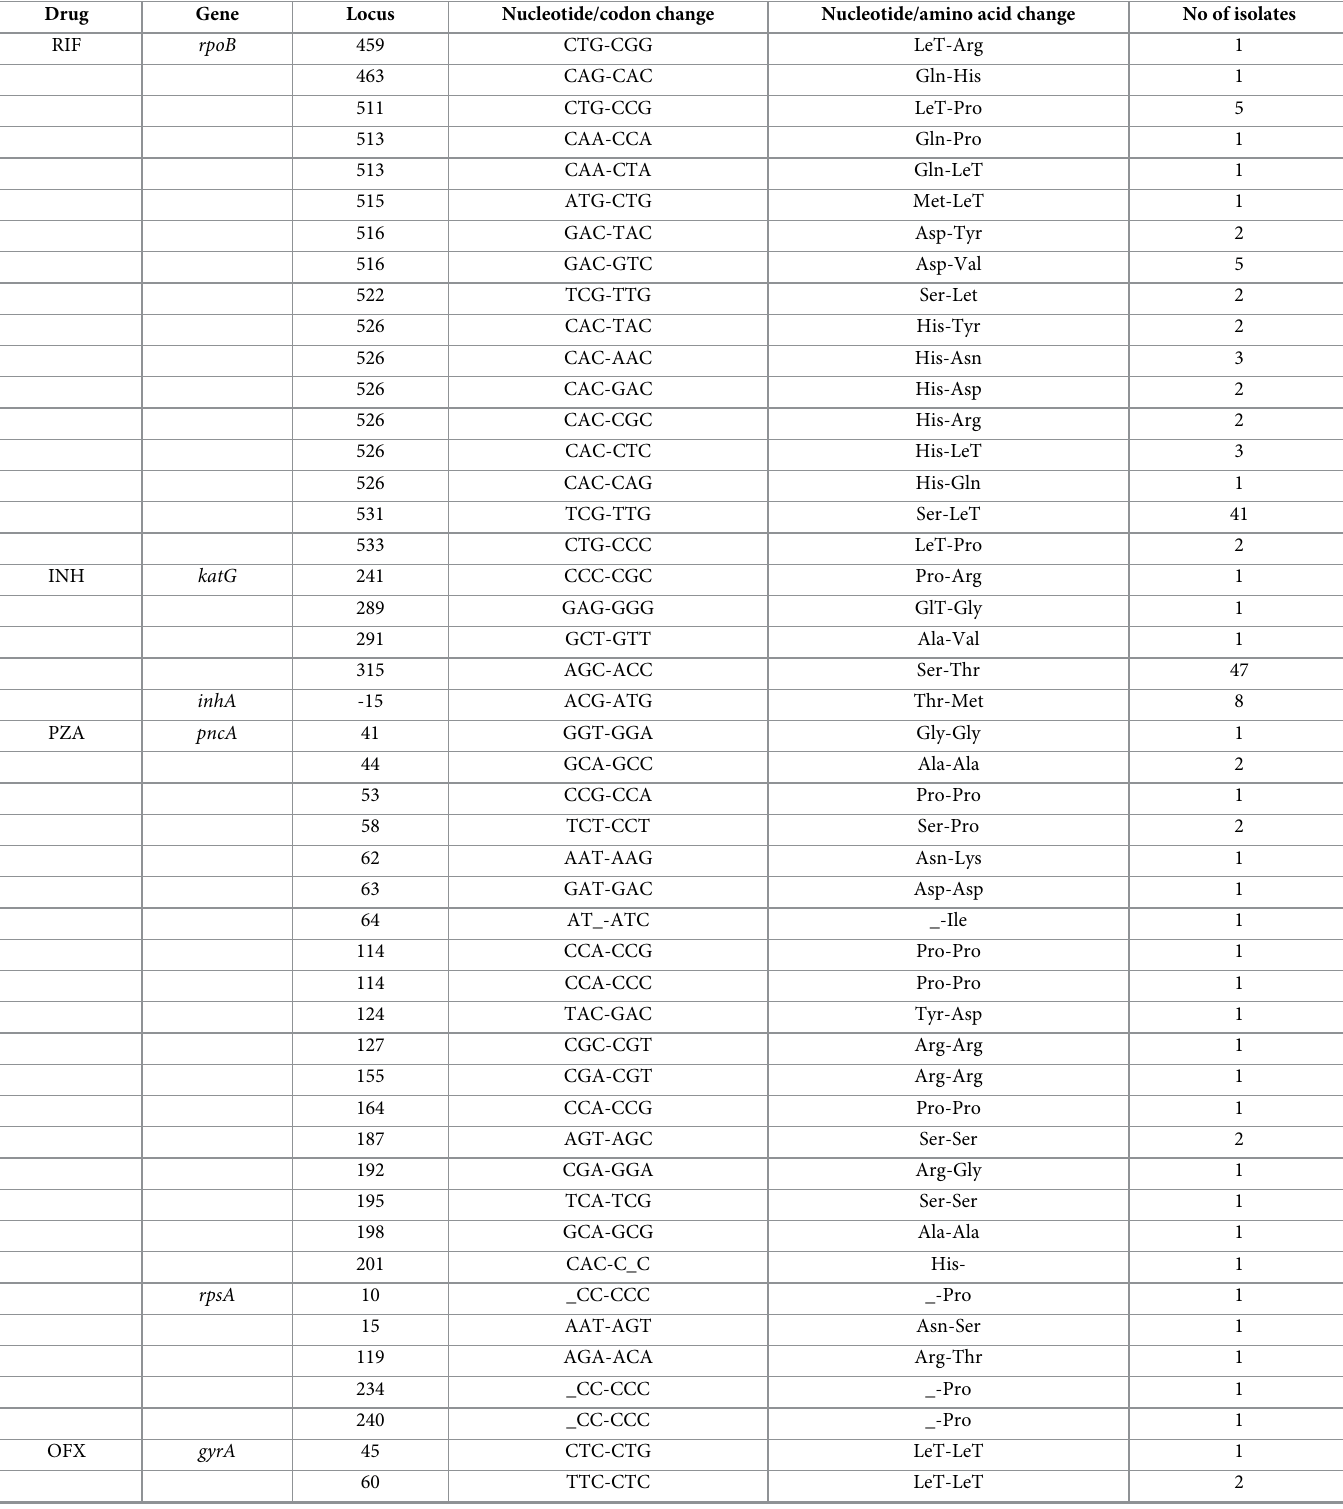
Table 2. Genotypic and phenotypic characteristics of resistance to anti-tuberculosis drugs.